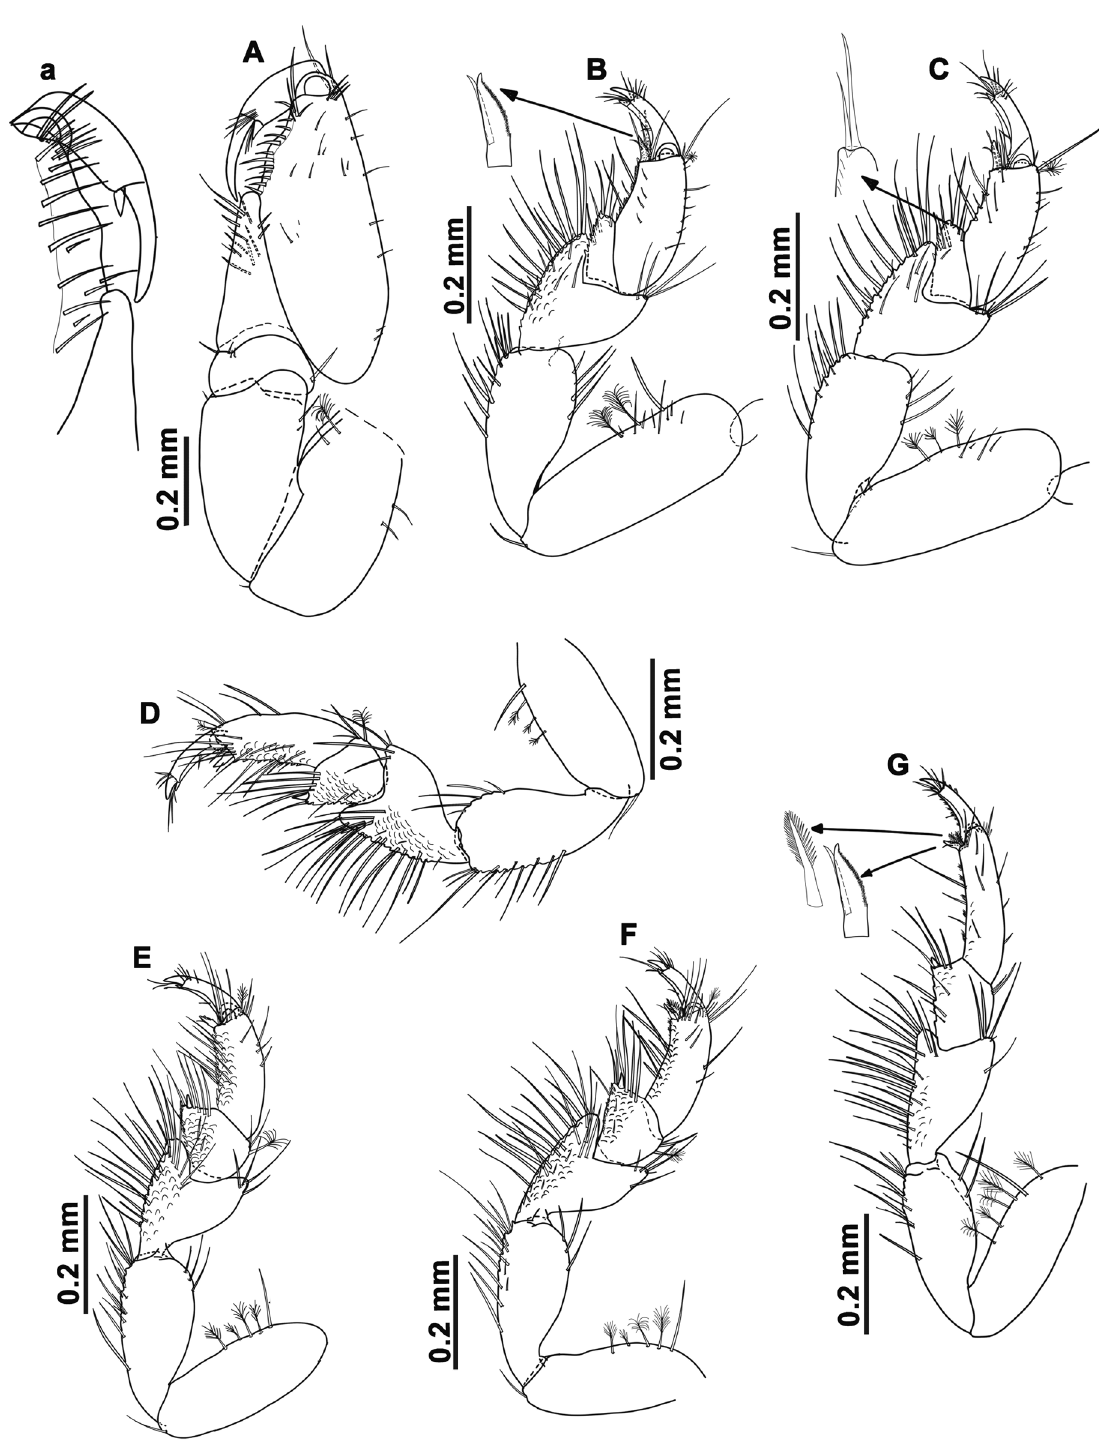
Fig. 6. Cortezura caeca sp. nov., holotype, ♀, 7.1 mm, Oaxaca, Huatulco, Jicaral Beach (UMAR-PERA 534). A . Pereopod 1 and detail of palm (a). B . Pereopod 2 and detail of the sensory spine. C . Pereopod 3 and detail of carpus. D . Pereopod 4. E . Pereopod 5. F . Pereopod 6. G . Pereopod 7 and detail of the sensory